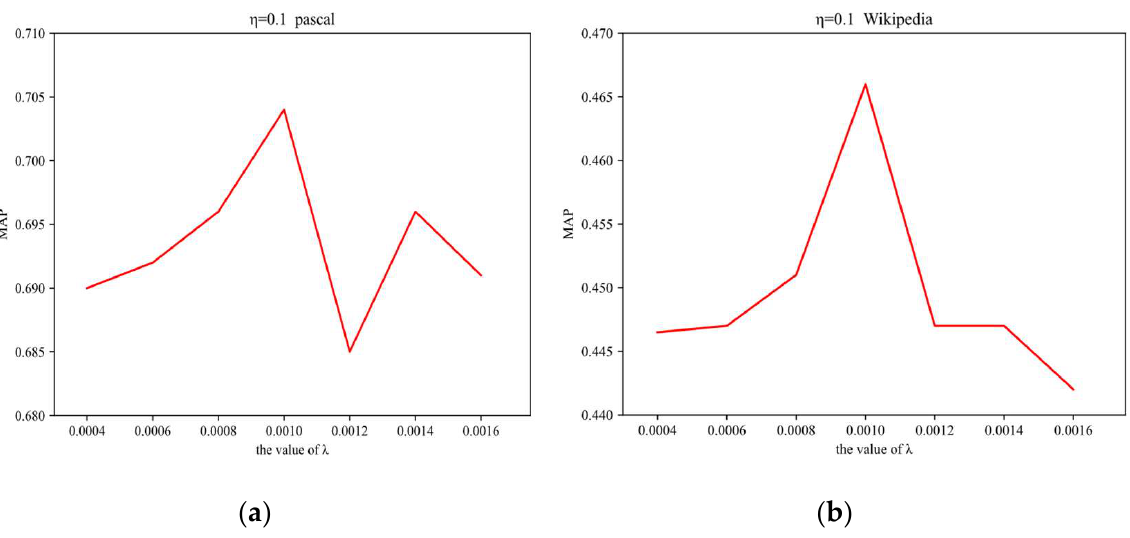
Figure 8. The cross-modal retrieval performances with different λ values. ( a ) The cross-modal retrieval performances with different λ values and η = 0.1 on the Pascal Sentence dataset. ( b ) The cross-modal retrieval performances with different λ values and η = 0.1 on the Wikipedia dataset.